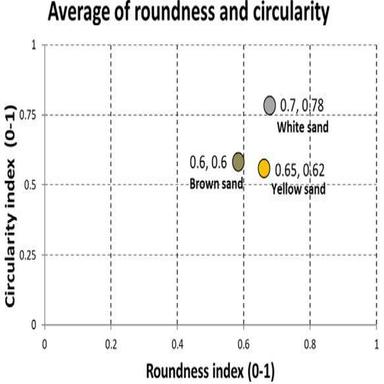
Average of roundness and circularity.